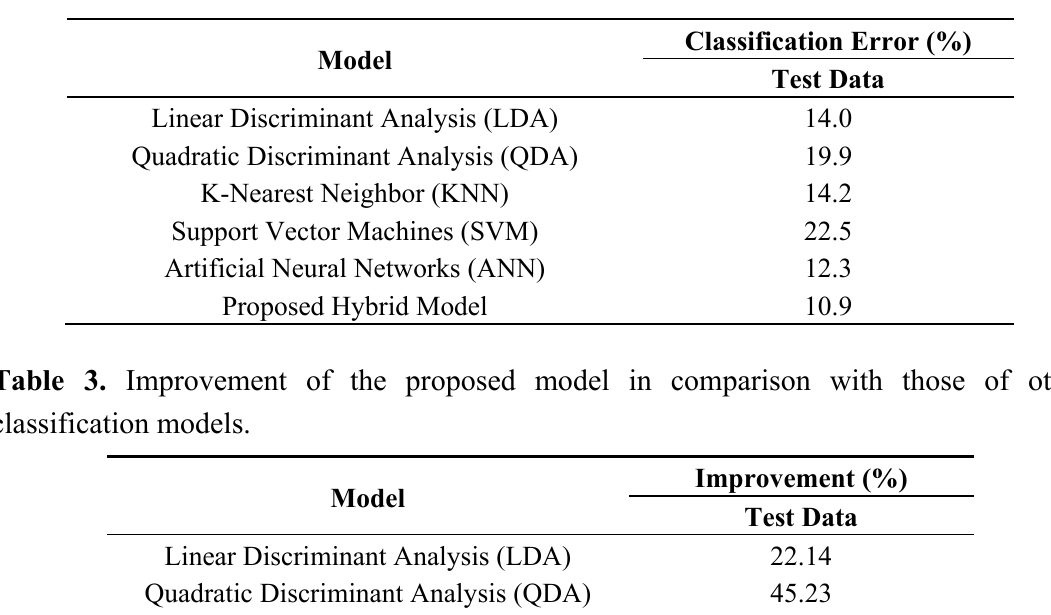
Table 2. Misclassification rate of classification models for Australian credit data set.